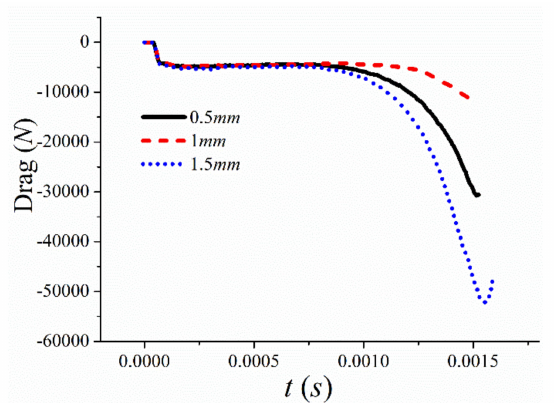
Figure 22. Drag with di ff erent α along the Z